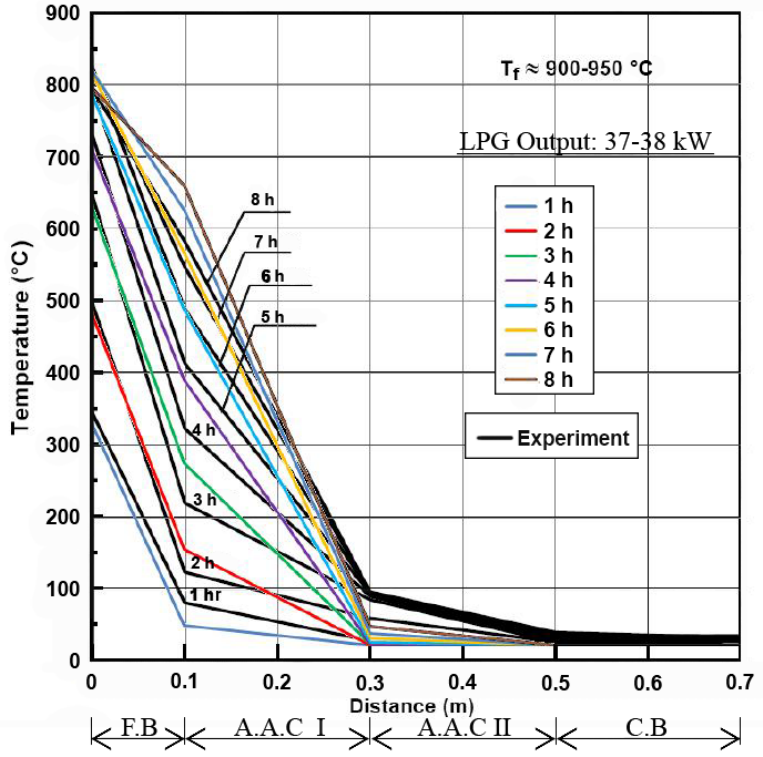
Figure 5. Superposition of the experimental (black) and computational (in color) results for the temperature distribution across the layers of the hot